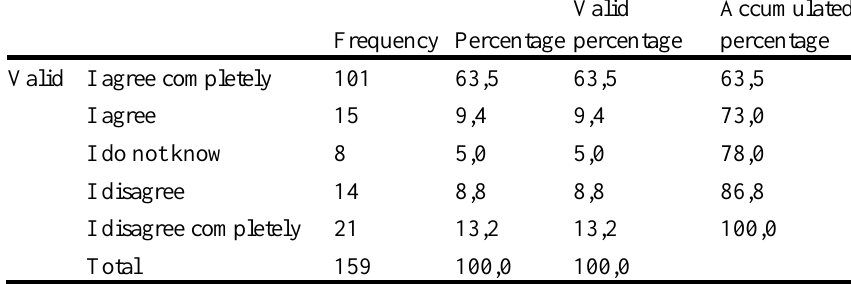
Valid percentage questionnaires´ results, question 3